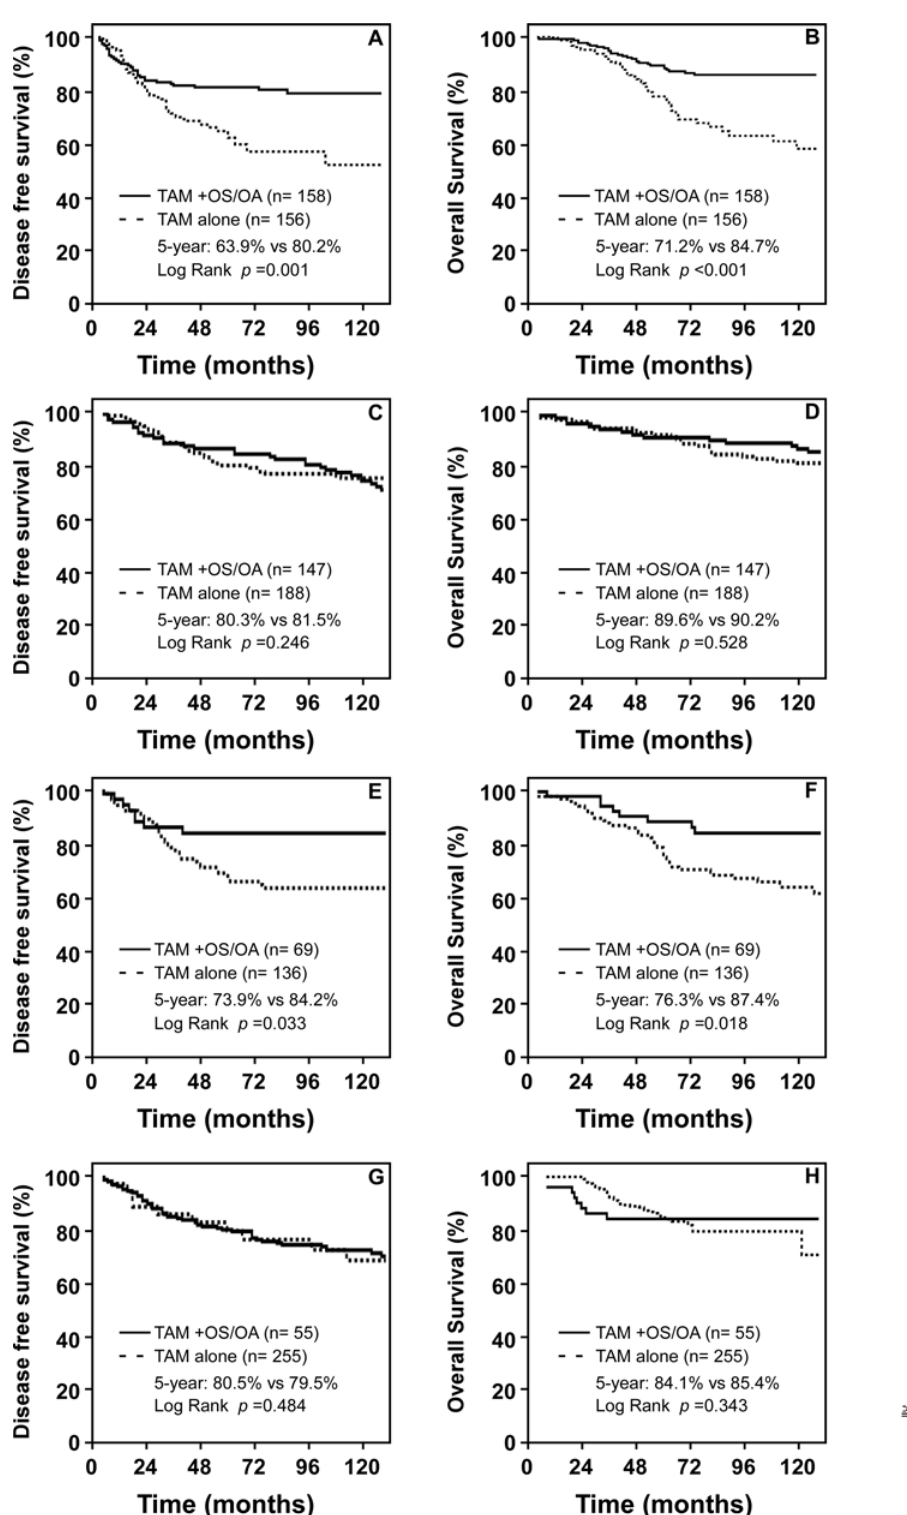
Fig 3. Survival curves by endocrine therapy (tamoxifen vs. tamoxifen + OS/OA). (A) and (B), DFS and OS of patients < 40 y/o + normal menses; (C) and (D), DFS and OS of patients < 40 y/o + amenorrhoea; (E) and (F), DFS and OS of patients (cid:1) 40 y/o + normal menses; G and H, DFS and OS of patients (cid:1) 40 y/o + amenorrhoea.